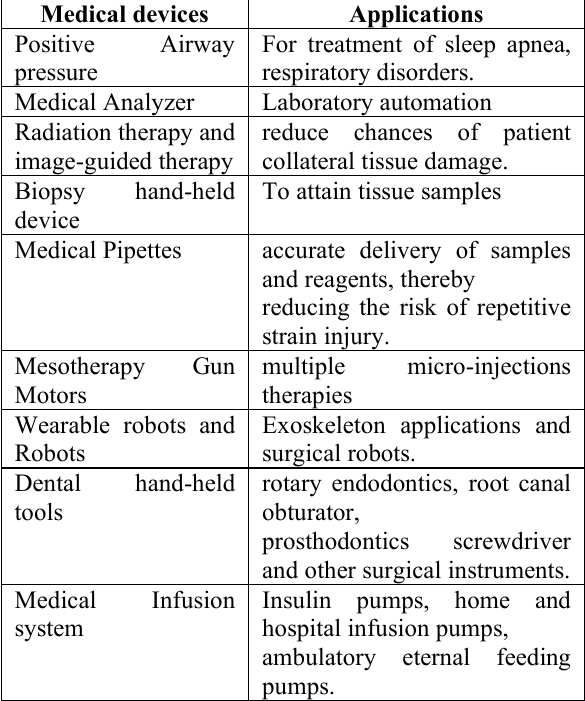
Table 2. DC motors in medical devices Medical